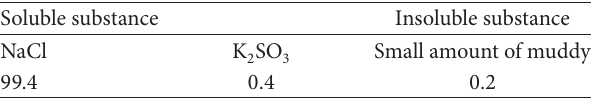
Table 1: Components of rock salt specimens (%). Soluble substance Insoluble substance NaCl K SO Small amount of muddy 2 3 99.4 0.4 0.2